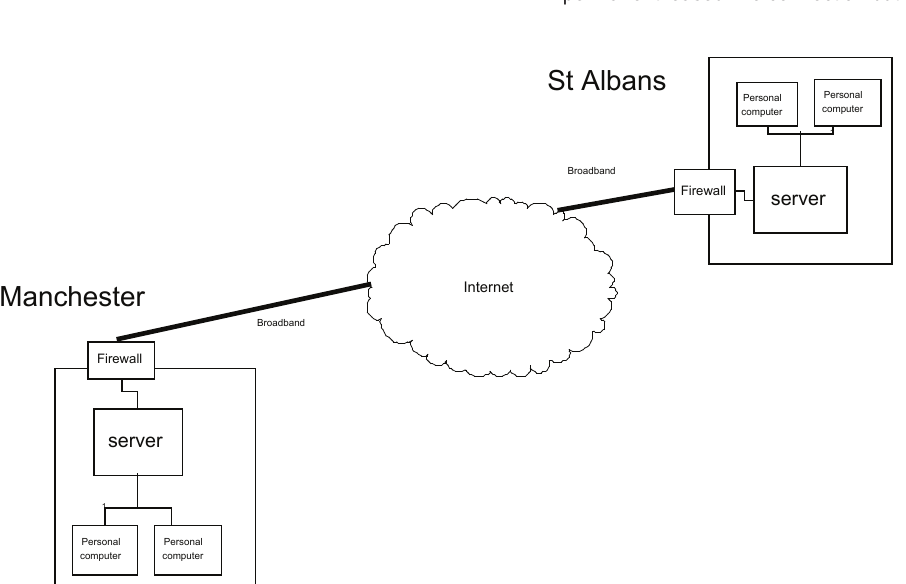
Figure 5: VPN (Virtual Private Network) between two